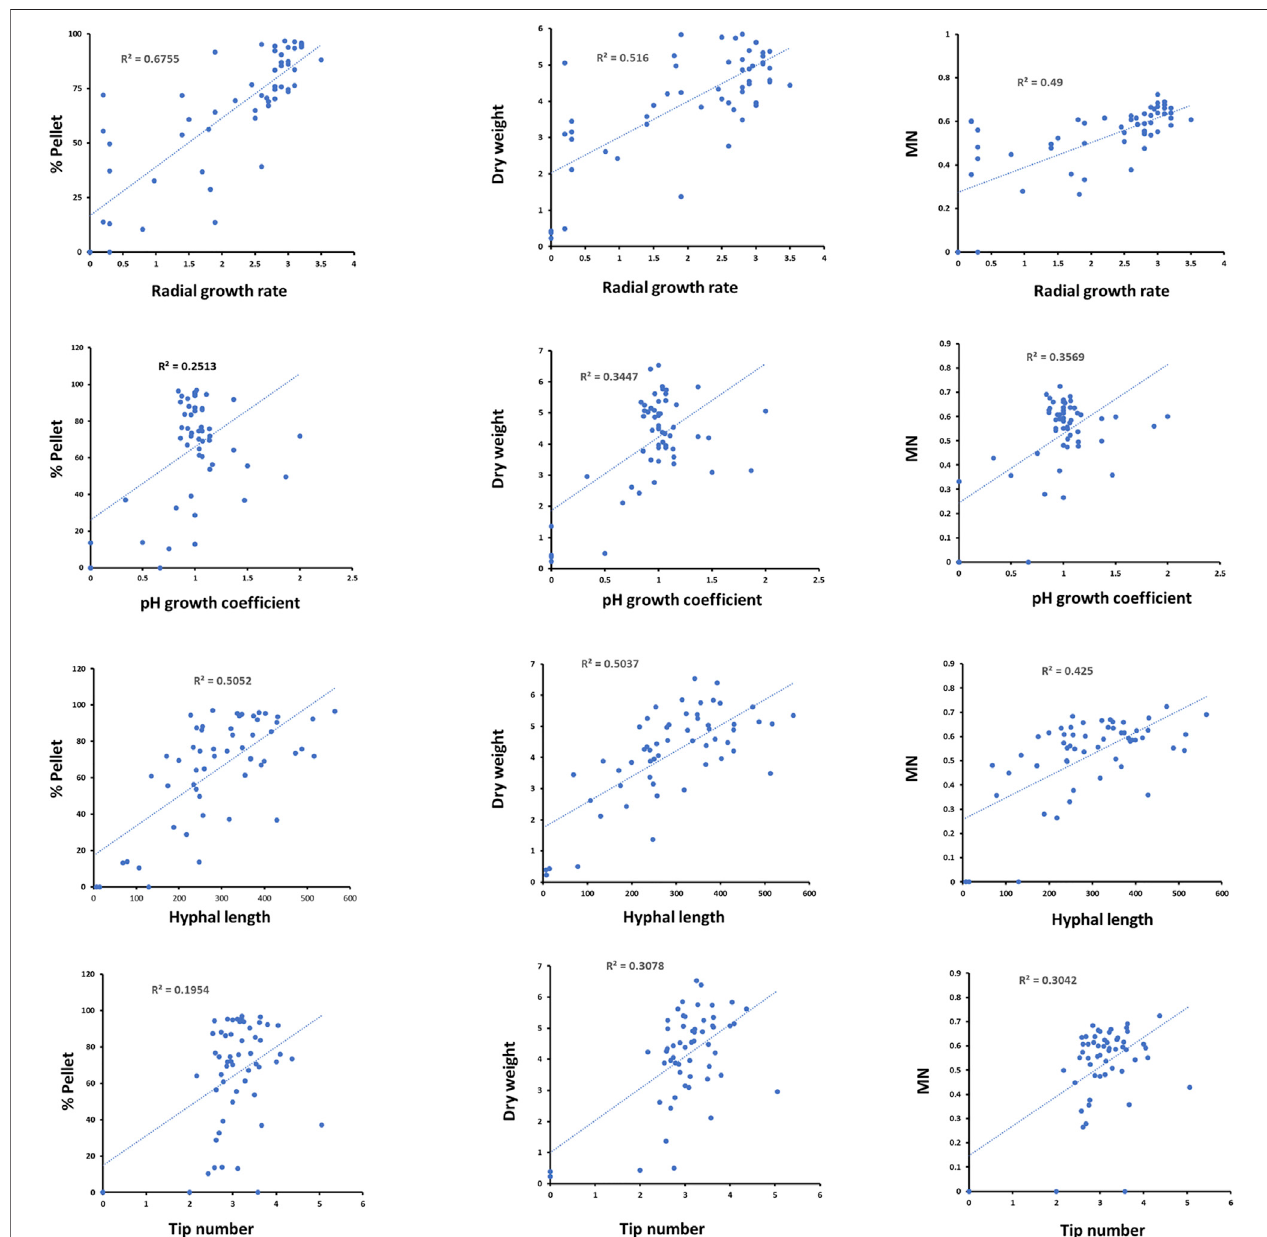
FIGURE 5 | Pairwise correlations between strain radial growth rates, pH growth coef fi cients, hyphal length and tip number with submerged growth parameters. Each blue dot represents correlations between the indicated parameters at a speci fi c strain/Dox concentration ( n (cid:2) 56). Line of best fi t and R 2 values are given.